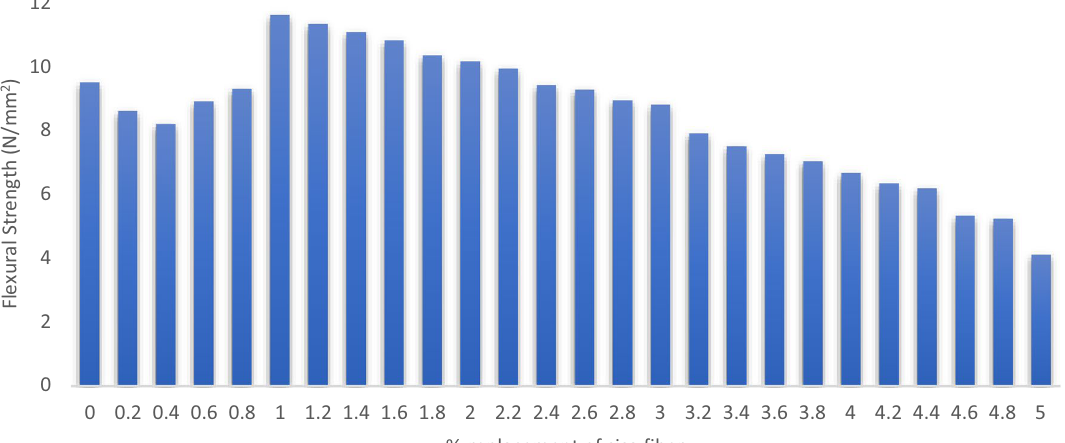
Figure 7. Flexural strength